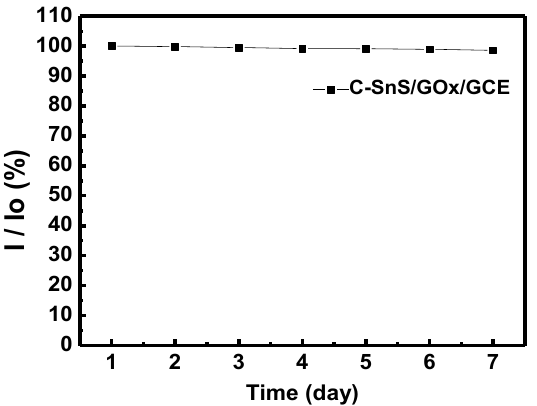
Figure 11. The performance stability of the C-SnS/GO x /GCE sensor for 7 days, where 0.1 mM glucose was used.